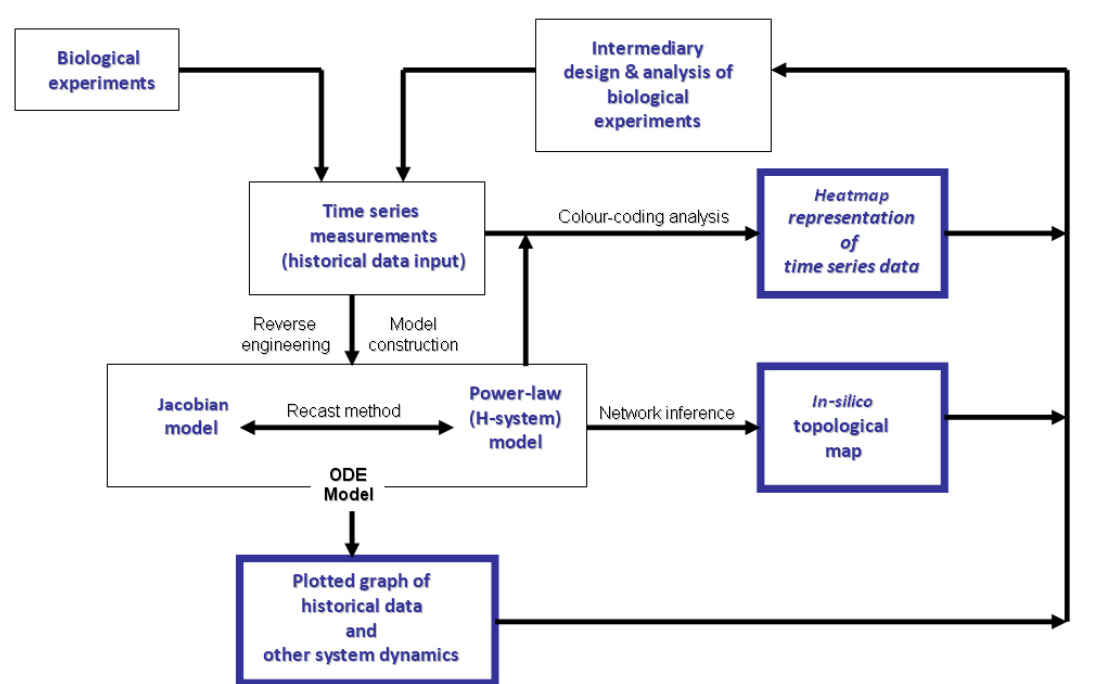
Figure 3. A dynamic modelling and reverse engineering strategy for analysing time series data of DNA Damage Response (DDR) pathway to infer and construct a data-consistent predictive model of the